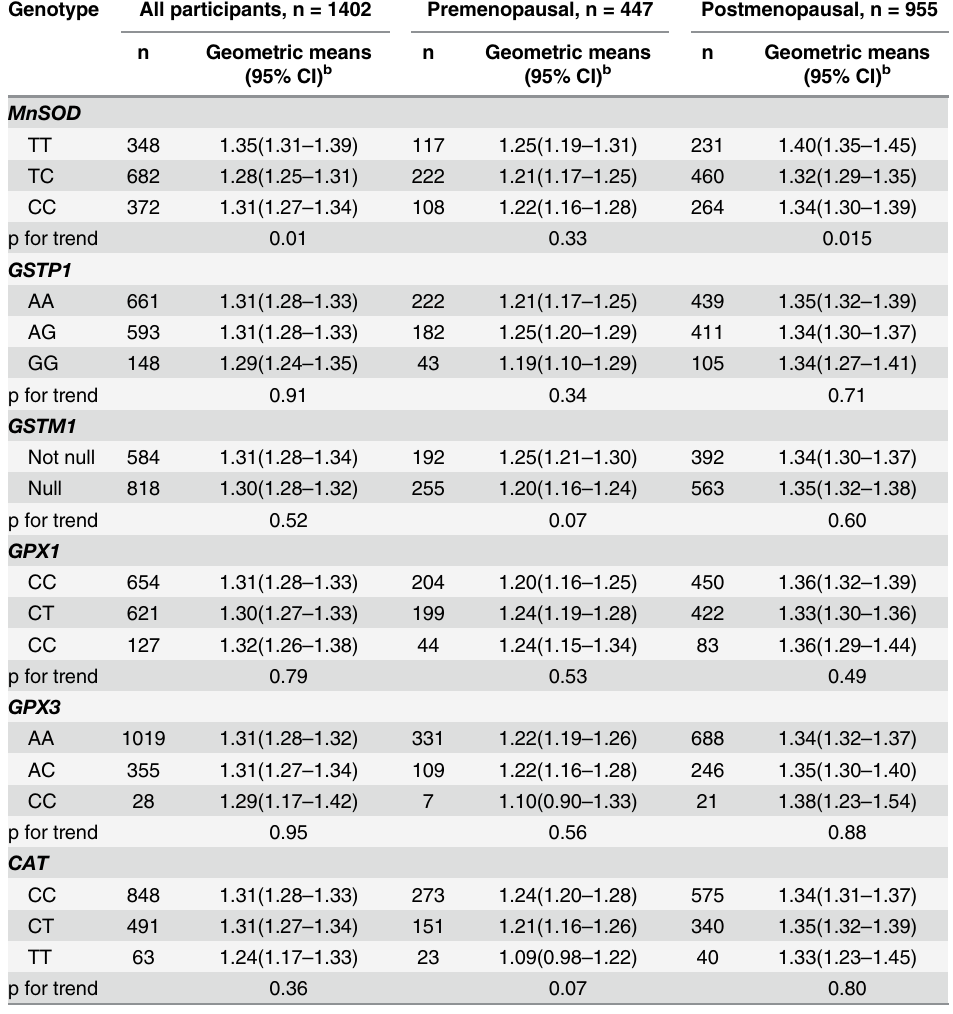
Table 2. Geometric means for TBARS by MnSOD , GSTP1 , GSTM1 , GPX1 , GPX3 , and CAT genotypes, WEB study controls, Erie and Niagara counties, 1996 – 2001 a